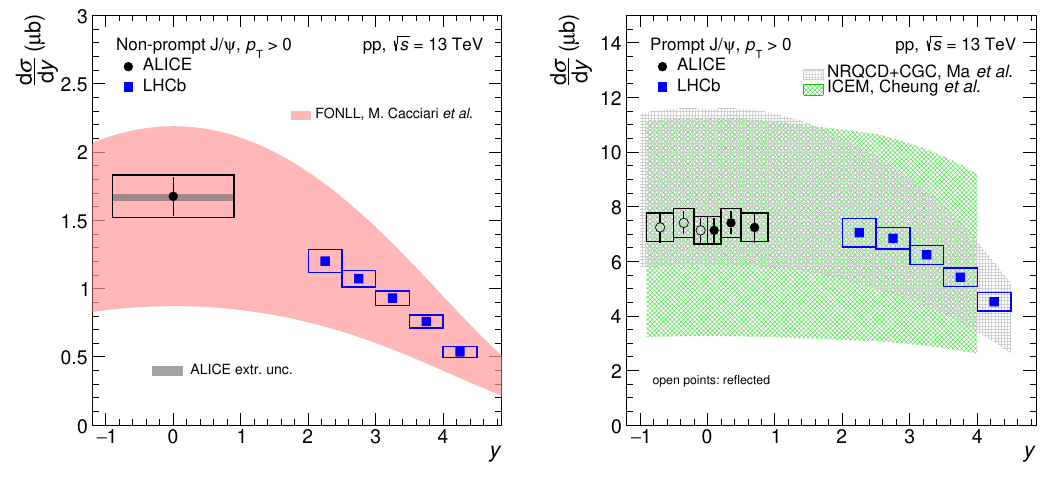
Figure 5 . Left panel: the d σ of non-prompt J /ψ extrapolated down to p T = 0 at midrapidity d y √ computed by the ALICE collaboration compared with similar measurements in pp collisions at s = 13 TeV carried out at forward rapidity by the LHCb collaboration [31]. Right panel: the d σ d y √ of prompt J /ψ as a function of the rapidity in pp collisions at s = 13 TeV. The results close to midrapidity are based on the ALICE measurements extrapolated down to p T = 0, and closed (open) symbols represent measured (reflected) data points (see text for details). Similar results obtained by the LHCb collaboration [31] at forward rapidity are shown as well. The theoretical calculations are from refs. [38, 60, 61,